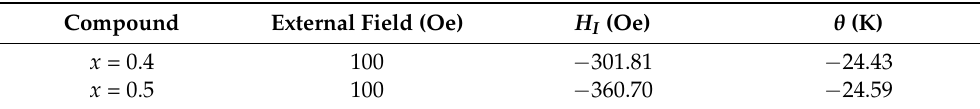
Table 2. List of fitting parameters for negative magnetization of M – T curves in FC mode as shown in Figure 6a,b. Compound External Field (Oe)